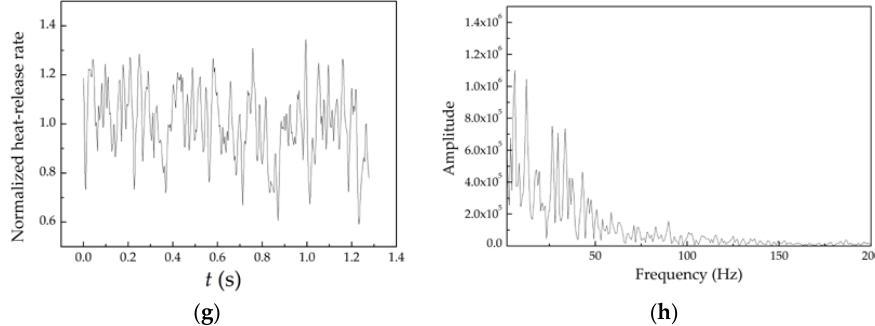
Figure 9. Flame heat-release rate pulsation curves and corresponding spectrum curves for primary air mass flow rate: ( a ) pulsation curve at ṁ pri = 95 g/min; ( b ) spectrum curve at ṁ pri = 95 g/min; ( c ) pulsation curve at ṁ pri = 100 g/min; ( d ) spectrum curve at ṁ pri = 100 g/min; ( e ) pulsation curve at ṁ pri = 105 g/min; ( f ) spectrum curve at ṁ pri = 105 g/min; ( g ) pulsation curve at ṁ pri = 110 g/min; ( h ) spectrum curve at ṁ pri = 110 g/min.